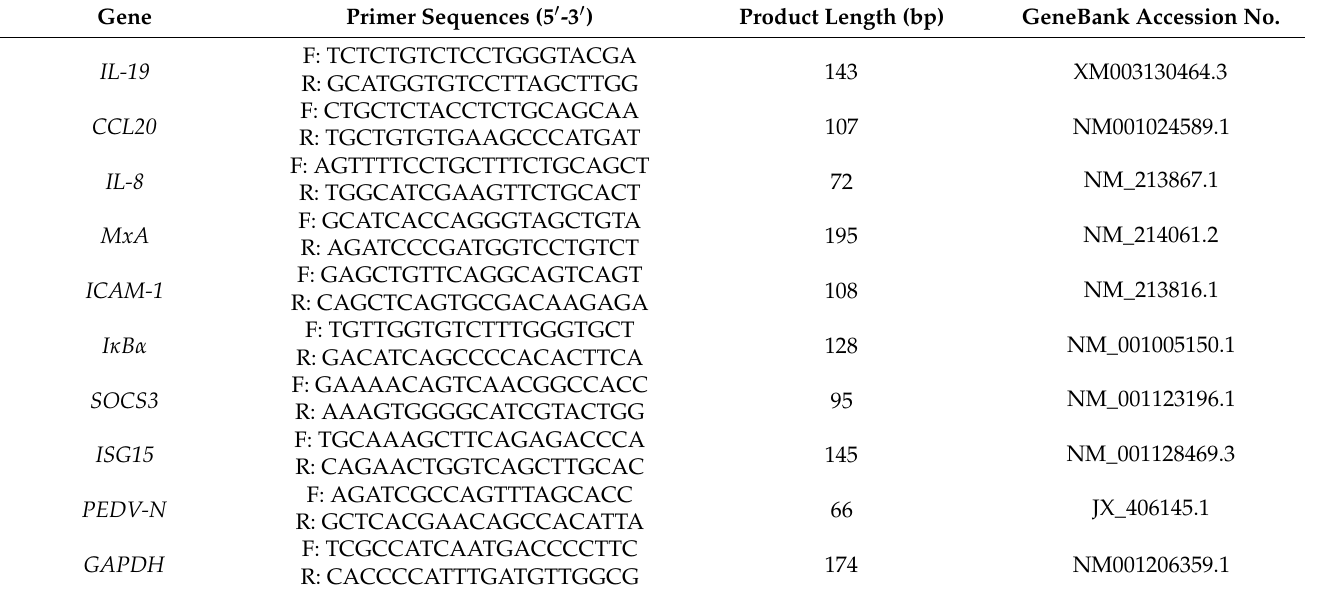
Table 3. Primer sequences of the target and reference